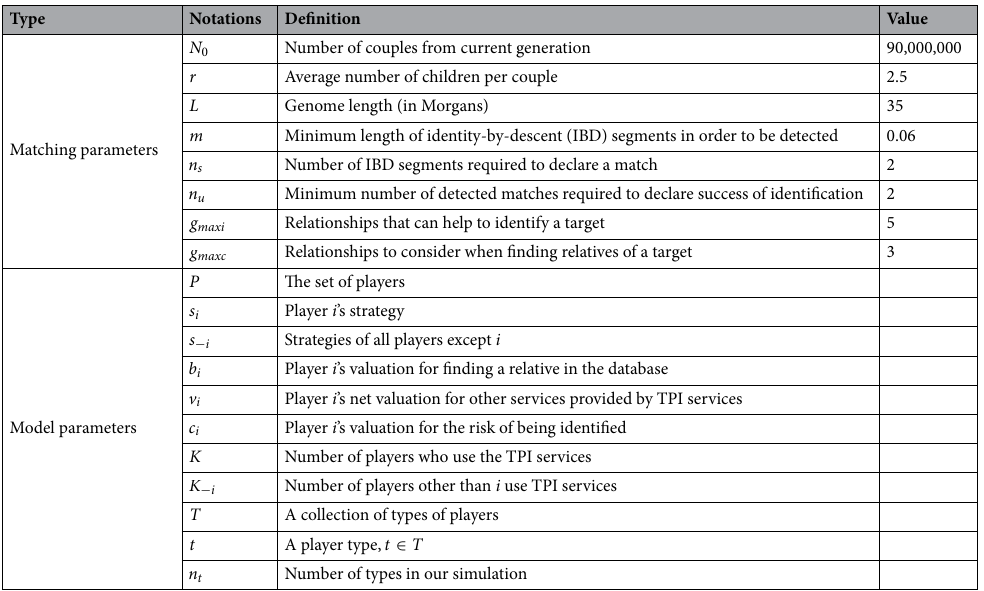
Table 1. Matching parameters and model parameters used in this